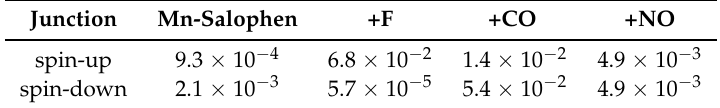
Figure 4. ( a ) The zero-bias spin-resolved transmission spectra of Mn-salophen molecular junction without chemical adsorption, ( b – d ) for Mn-salophen molecular junctions with F, CO, and NO adsorptions. Here, the short-dotted vertical lines stand for the Fermi level for clarity, while the red and blue lines stand for the spin-up and spin-down electrons, respectively, while the inserts in ( b , c ) stands for the spatial distribution of the perturbed HOMO of the spin-up and spin-down electrons. Table 2. Conductances (in G 0 ) at the Fermi level for four examined molecular